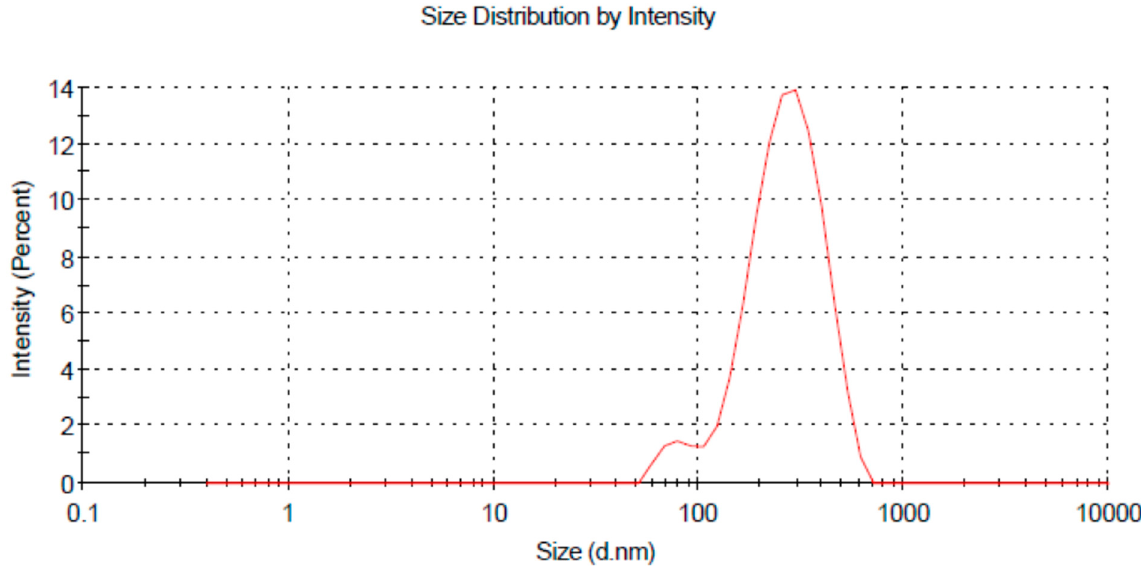
Figure 2. Size distribution by intensity of MNE.